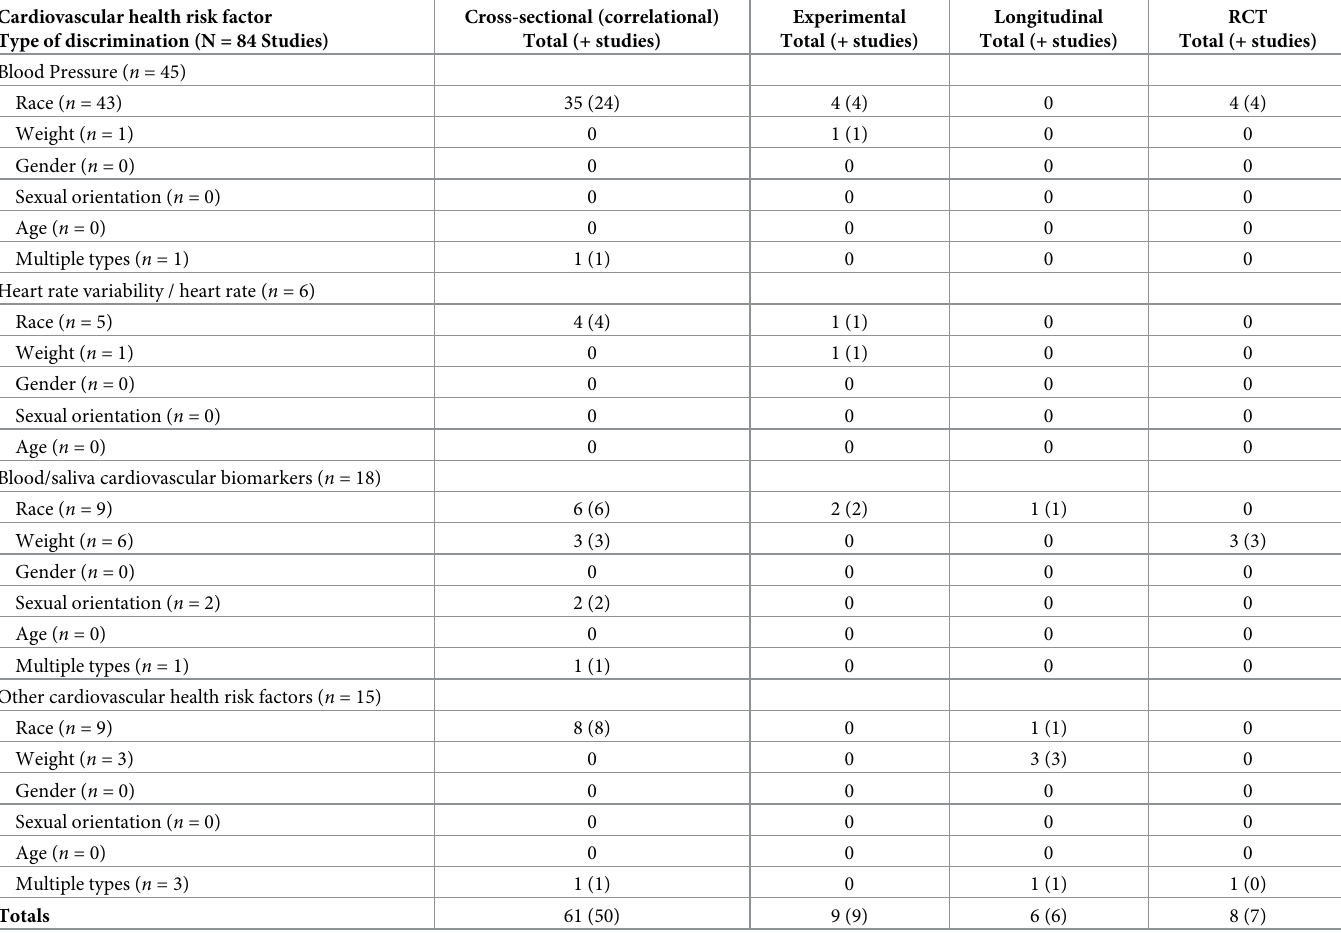
Table 4. Summary of evidence examining the links between discrimination and cardiovascular health among socially stigmatized groups. Cardiovascular health risk factor Type of discrimination (N = 84 Studies)